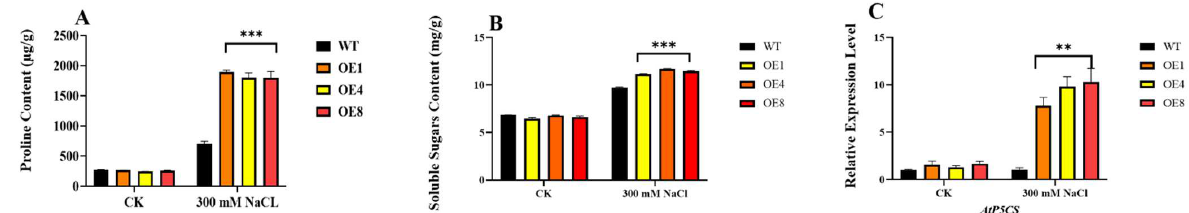
Figure 6. Osmotic stress analysis of PcWRKY11 overexpression plants under salt stress. ( A ) Proline content in the wild-type and transgenic lines under normal conditions and the salt treatment condition. ( B ) Soluble sugar content in the wild-type and transgenic lines under normal conditions and salt treatment conditions. ( C ) The expression of the proline synthesis gene AtP5CS in plants. The mean values and standard errors were calculated with three independent experiments. **, and *** represent a significance level of, p < 0.01, and p < 0.001, respectively; WT, wild-type plants; OE, overexpressed plants CK, under normal conditions.